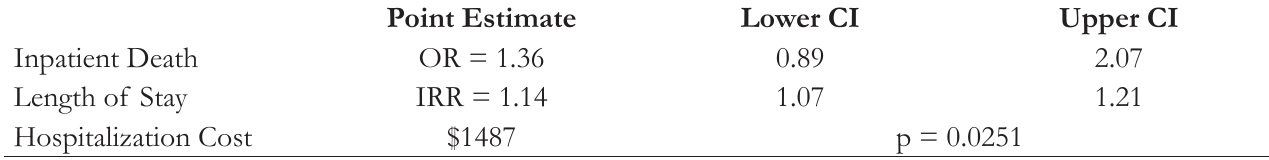
Table 3. Outcomes Associated with AATD